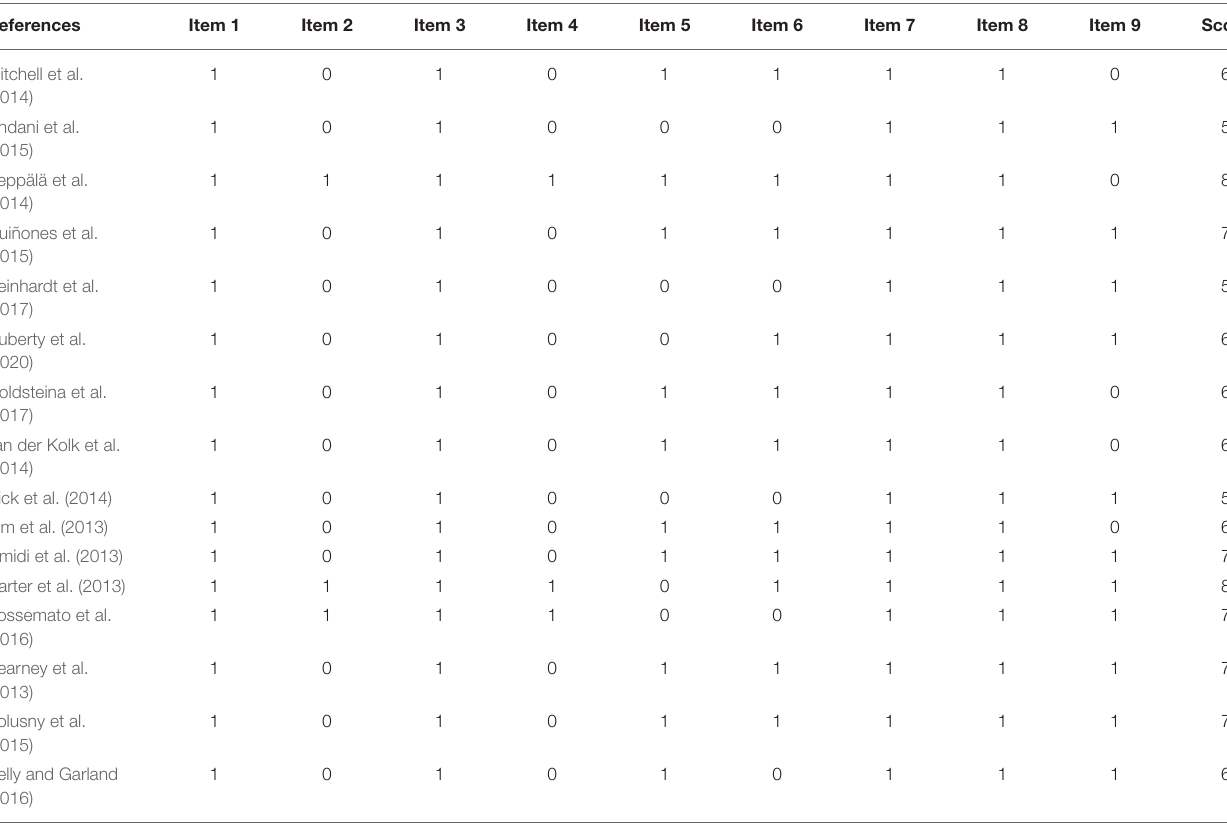
TABLE 2 | Study quality assessment for eligible randomized controlled trials.